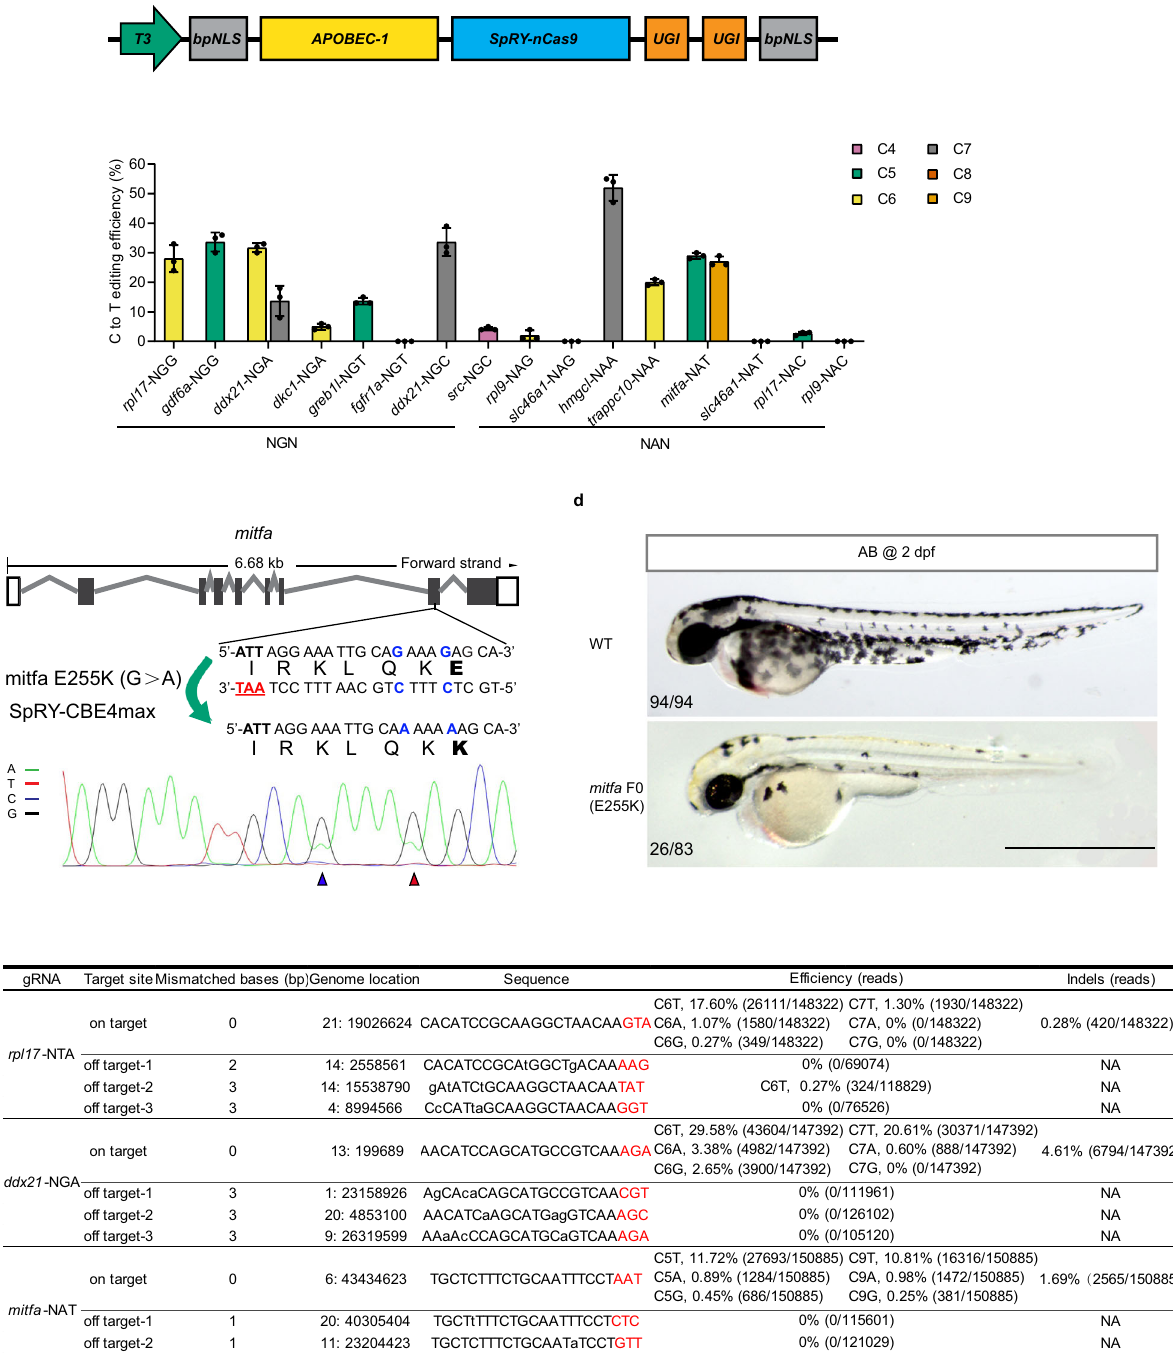
Fig. 3 Ef fi cient cytosine base editing mediated by SpRY-CBE4max across various PAMs. a The mRNA construct of SpRY-CBE4max used for cytosine base editing in zebra fi sh. b Summary of C-to-T base editing ef fi ciency of various loci with NRN PAMs induced by SpRY-CBE4max editor in zebra fi sh. The position of the editing base in the gRNA was labelled with numbers. (Values are presented as mean value ± standard deviation (SD), n = 3 biological replicates) c Schematic diagram and sequencing results of mitfa (E318K) mutation induced by SpRY-CBE4max. The PAM sequences are underlined in red, the detected nucleotide changes are highlighted in blue, the targeted amino acids are highlighted in bold, the nucleotide substitutions are indicated by a red arrowhead in the sequencing chromatograms, and the synonymous mutations induced by SpRY-CBE4max are indicated with a blue arrowhead. d Lateral view of 2 dpf F0 embryos injected with mitfa (E318K) gRNA and SpRY-CBE4max mRNA showing pigmentation defects. Scale bar: 1 mm. This experiment was repeated three times independently with similar results. e On-target, product purity and off-target analysis of SpRY-CBE4max induced C-to-T editing at rpl17 -NTA, ddx21 -NGA and mitfa -NAT sites using NGS. The PAM sequences are underlined in red. NA: Not Applicable. All source data in this fi gure are provided as a Source data fi